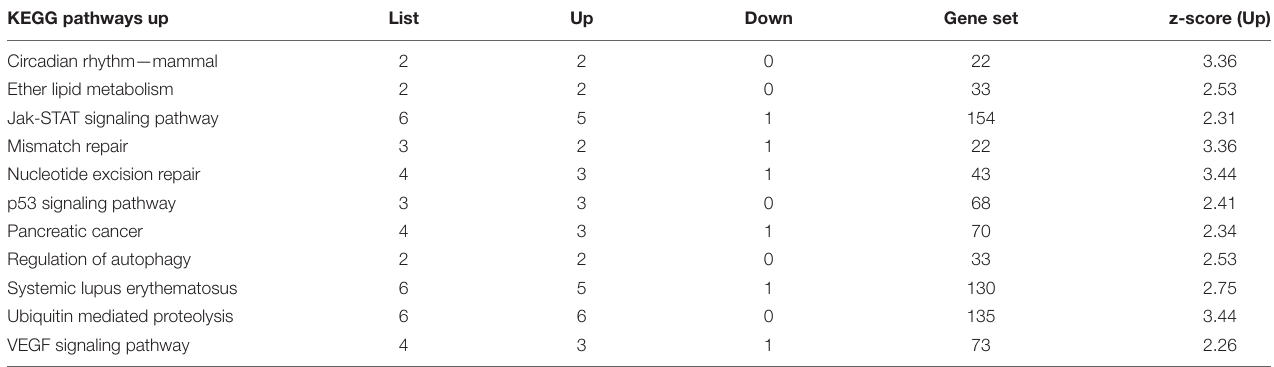
TABLE 5 | Up-regulated KEGG pathways in PHT cells in response to rictor silencing. KEGG pathways up List Up Down Gene set z-score (Up) Circadian